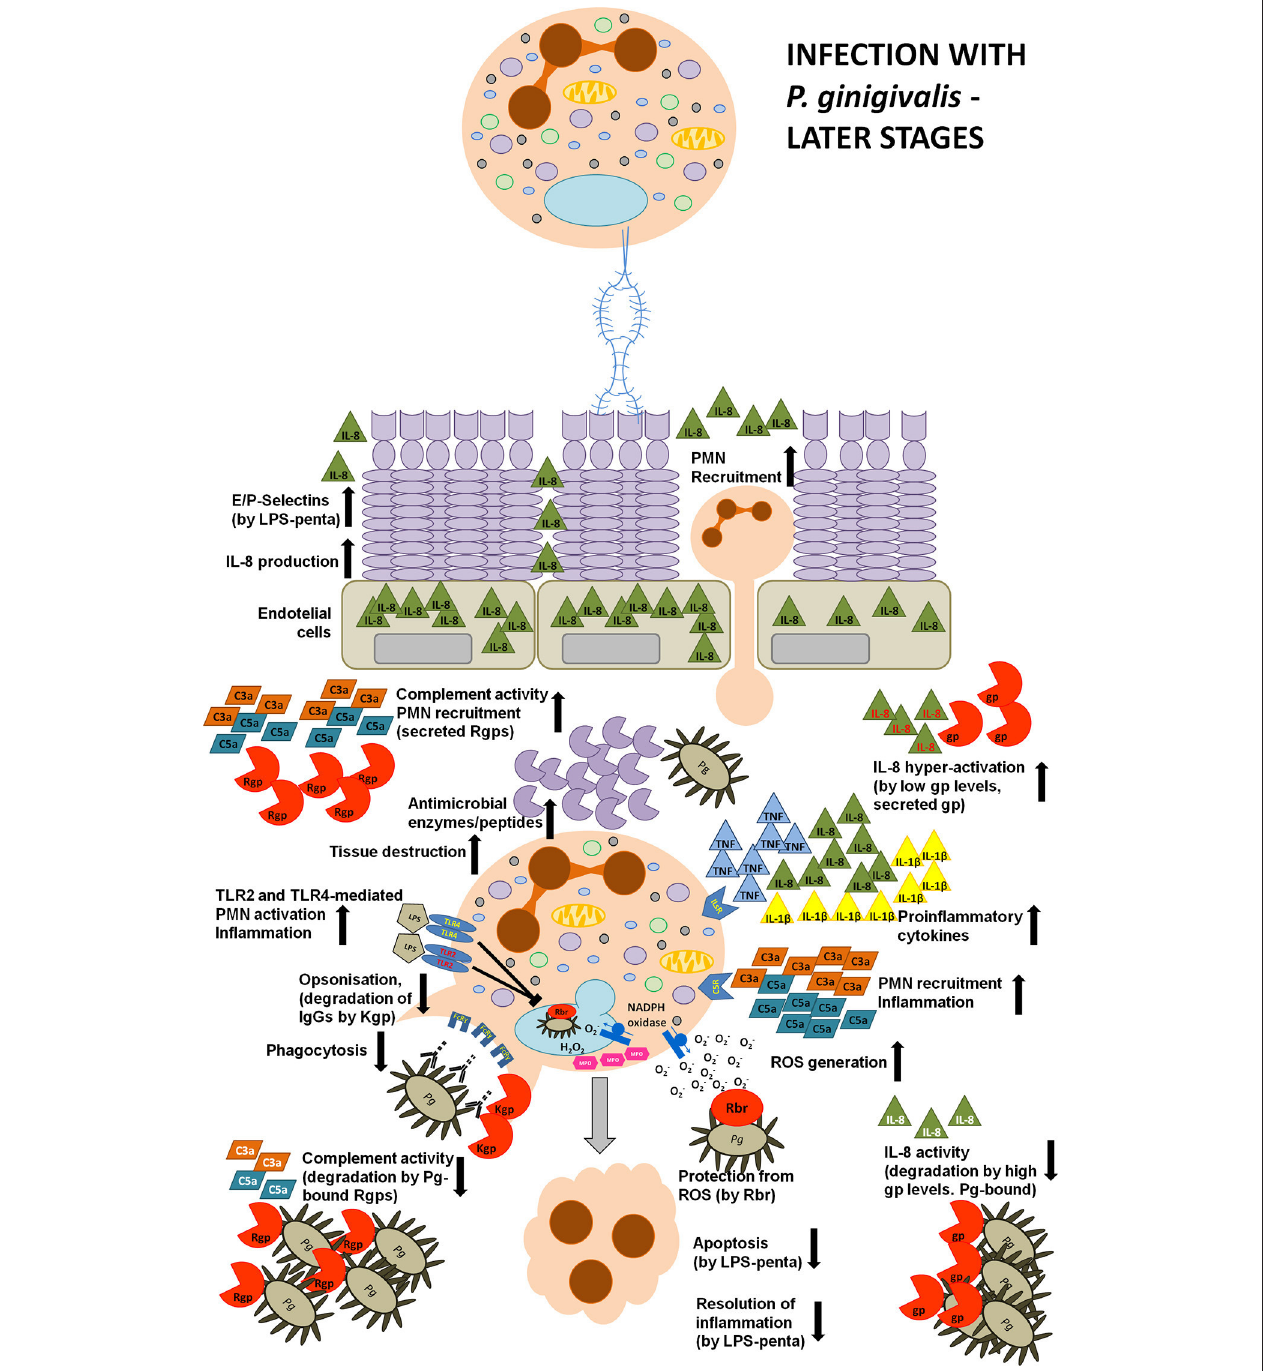
FIGURE 3 | Manipulation strategies of neutrophils and the immune system by P. gingivalis at the later phase of infection. During a later phase of the infection P. gingivalis releases a penta-acylated LPS variant leading to the increased expression of L- and P-selectins on GECs and enhanced production of IL-8. This strongly stimulates neutrophil chemotaxis and transmigration to the site of infection. Moreover, P.g.-derived LPS and fimbriae strongly stimulate neutrophil pro-inflammatory and anti-bacterial responses, such as the secretion of reactive oxygen species and pro-inflammatory cytokines, and the production of anti-microbial peptides and enzymes. An elevated secretion of these anti-bacterial molecules results in gingival tissue destruction, while many virulence factors secreted by P. gingivalis protect this periodontopathogen from the consequences of hyper-inflammation. The keystone pathogen is protected from oxidative stress, as it expresses ruberythrin (Rbr) protein. Additionally, the expression of Lys-specific gingipains degrades immunoglobulins at the hinge region, and, coupled with the activation of the TLR2 signaling pathway (by LPS), abolishes bacterial opsonization and phagocytosis. Also, gingipains manipulate anti-bacterial responses by deregulating the complement cascade and IL-8-mediated neutrophil chemotaxis. In particular, depending on the concentration and the position of gingipains within the biofilm, these